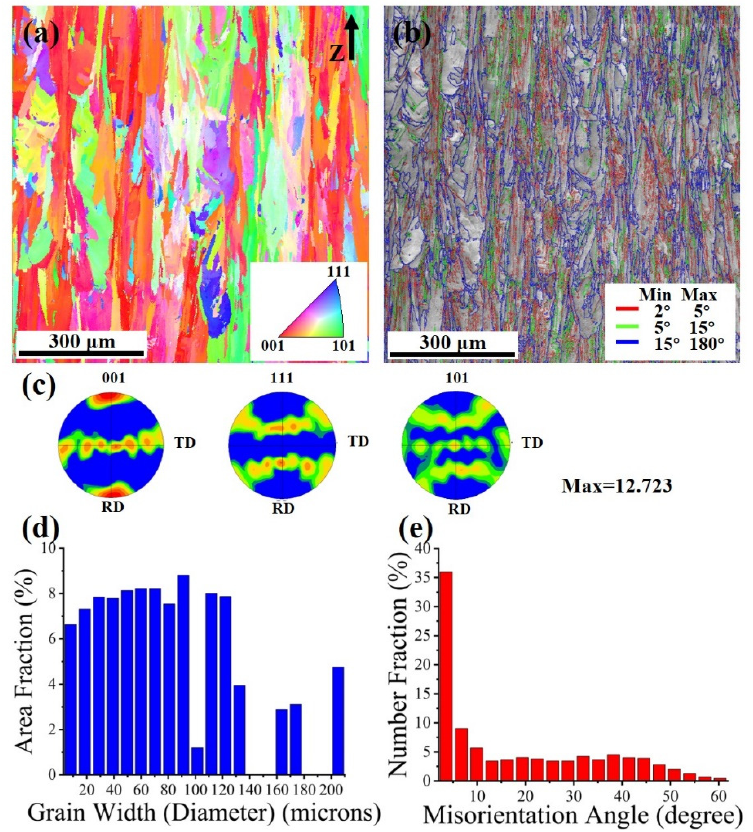
Figure 4. EBSD images of the FGH96 sample: ( a ) inverse pole figure; ( b ) grain boundary map; ( c ) pole figure; ( d ) grain size distribution; ( e ) misorientation angle statistics.